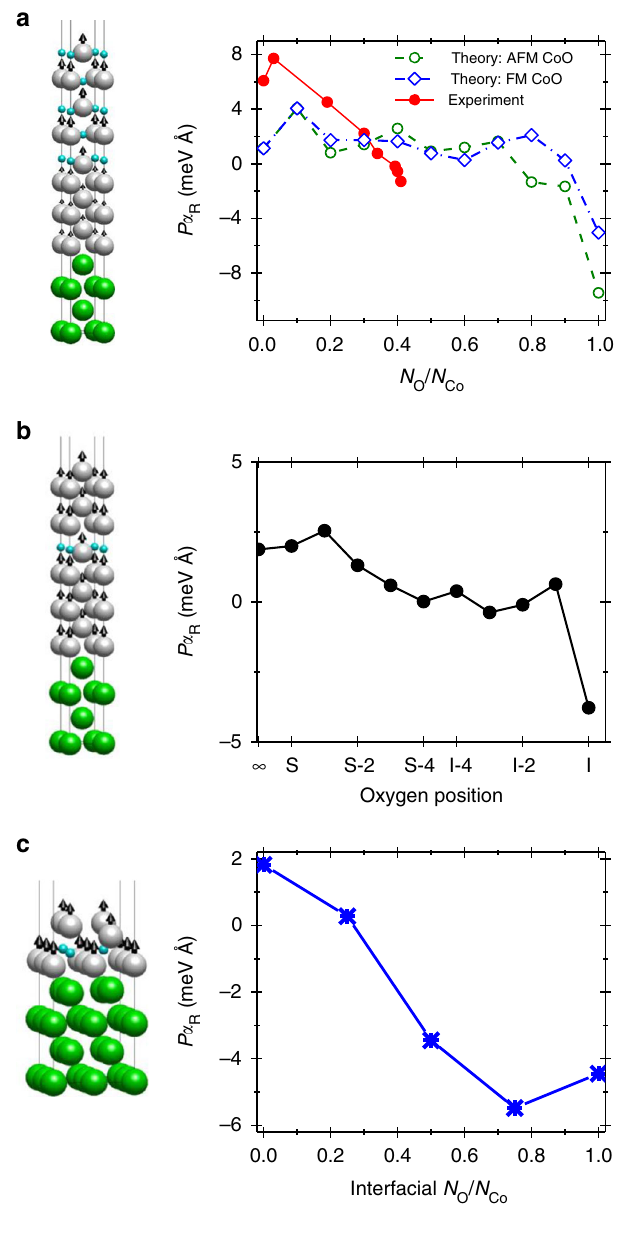
Fig. 4 Rashba spin – orbit coupling calculations. a Effective Rashba coef fi cient (ERC), P α R , as a function of oxygen concentration, x = N O / N Co , in the Pt (4 ML)/Co (10(1 − x ) ML)/CoO (10 x ML) slab for